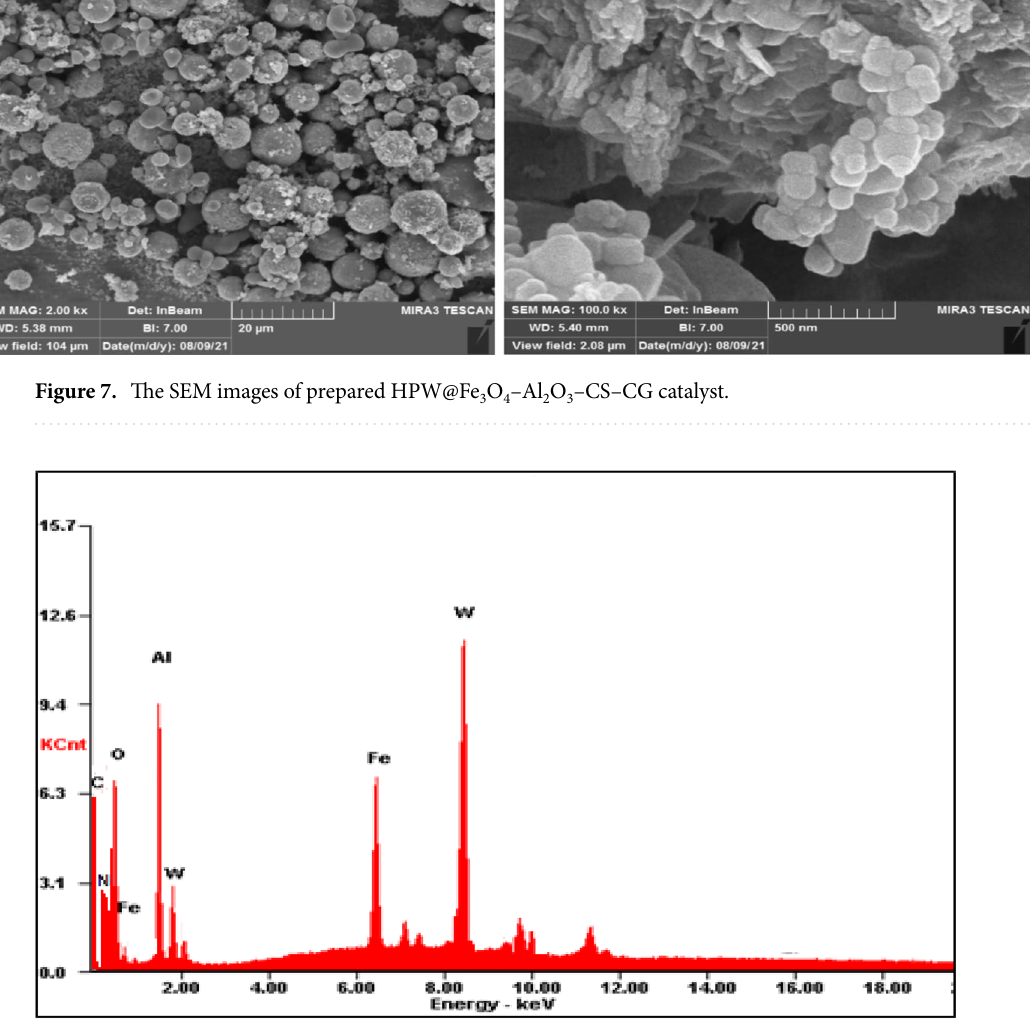
Figure 8. EDS analysis of HPW@Fe 3 O 4 –Al 2 O 3 –CS–CG